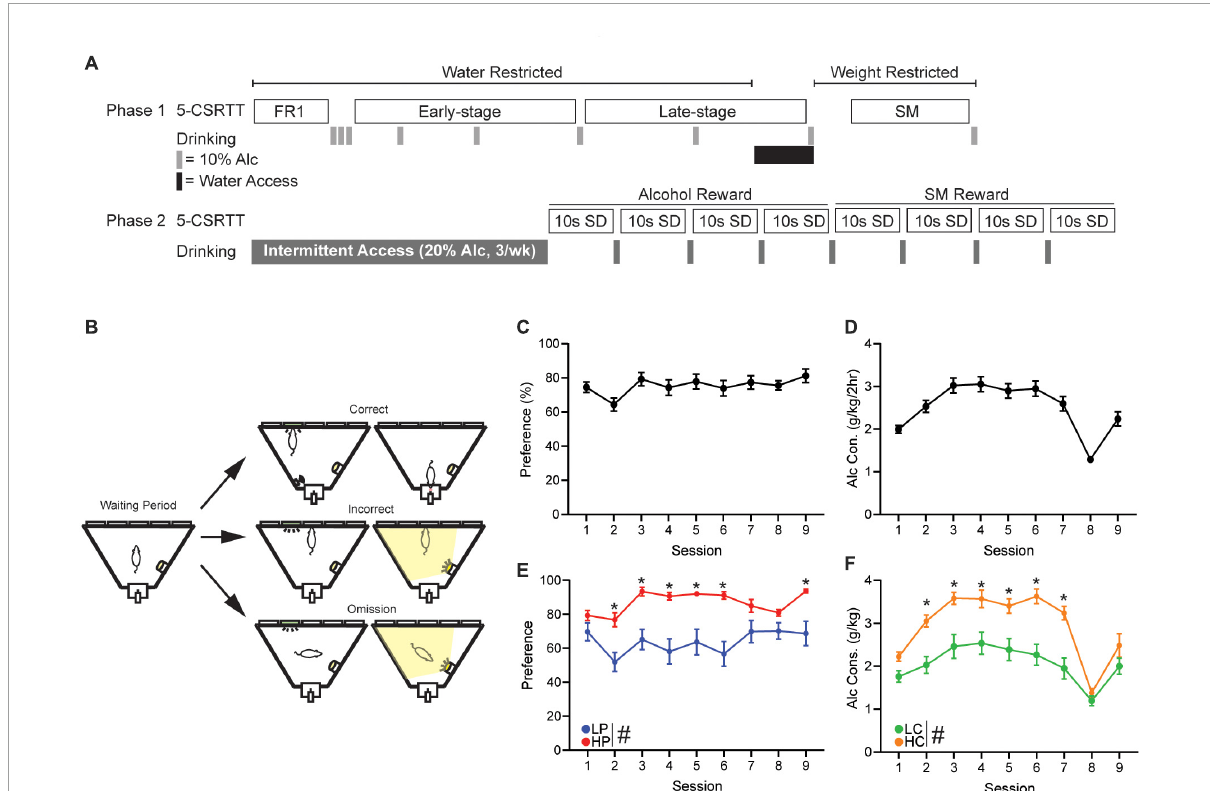
FIGURE1 5-Choice Serial Reaction Time Task training schedule and alcohol drinking. (A) Schedule of 5-CSRTT and drinking behavior. (B) Graphic detailing a correct, incorrect, and omission within the 5-CSRTT. Briefly, a head entrance into an illuminated reward tray initiates the waiting period. When the waiting period ends, a light will appear in 1 of 5 ports. A touch in the illuminated port is a correct response and will result in reward delivery. A touch in an unlit port is an incorrect response and will cause a punishing flash of light and no reward. If the lit port extinguishes and the limited hold period elapses, this will result in an omission causing a punishing flash and no reward. Overall (C) alcohol preference and (D) alcohol consumption of all mice, across the 9 days of 2-h DID two-bottle choice drinking (gray bars). (E) Alcohol preference when mice were separated by median split of preference (HPvLP: F 1 , 46 = 82.06, p < 0.0001). Post hoc revealed significance on sessions 2–6 and 9. (F) Alcohol consumption when mice were separated by median split of consumption ( F 1 , 46 = 81.31, p < 0.0001; time: F 6 . 11 , 279 . 4 = 18.30, p < 0.0001; interaction: F 8 , 366 = 2.22, p = 0.0253). Post hoc revealed significance on sessions 2–7. Session 8 reflects the time in which the mice were given 1 week of water access before being water restricted again. # p < 0.05 for group effect. * p < 0.05 post hoc significance. All data are expressed as ± standard error